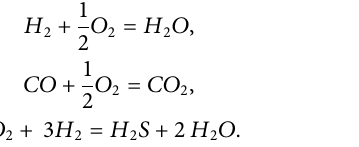
TABLE 1 | Table to summarize the gas composition collected using Multi-GAS, AF pack, and FTIR. Details of all datasets can be found in Supplementary Material S1 .